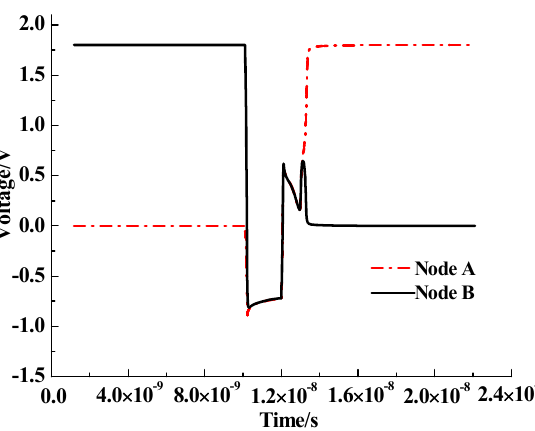
Figure 7. The storage node potentials as a function of time for SESD.